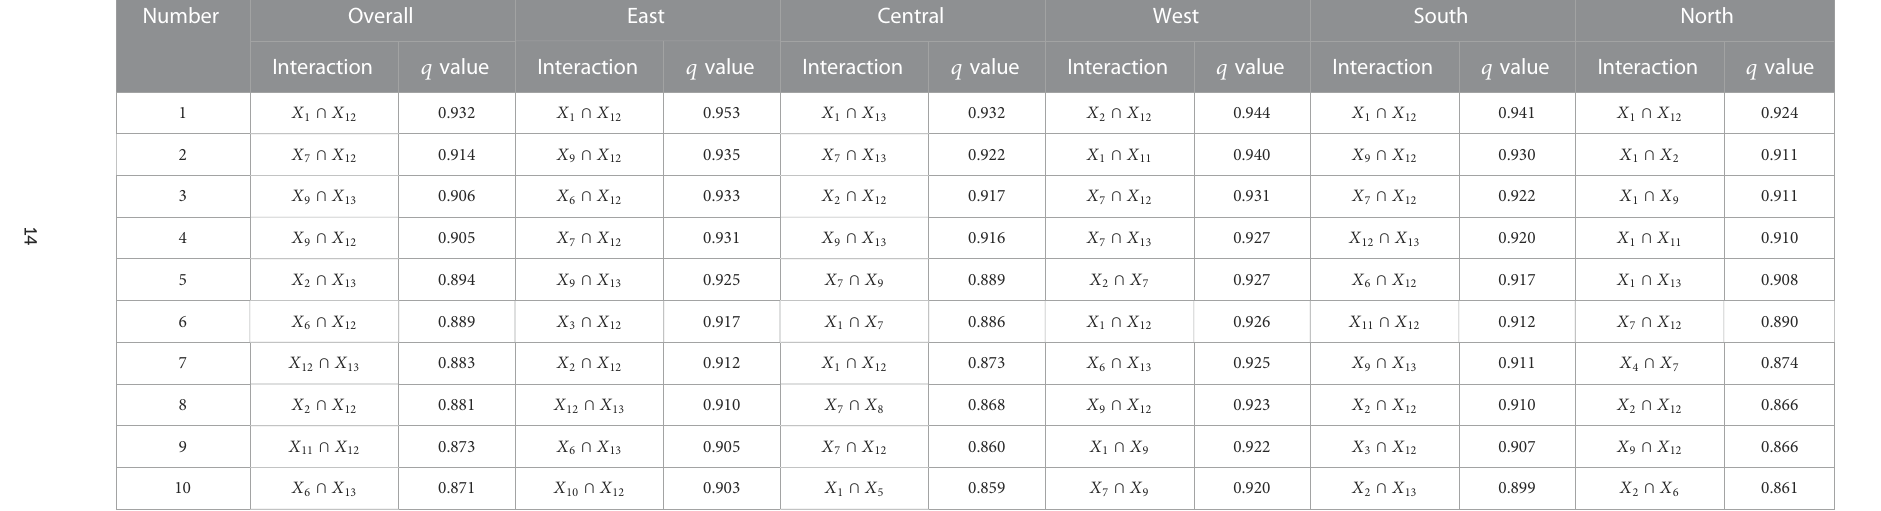
TABLE 5 Interaction between